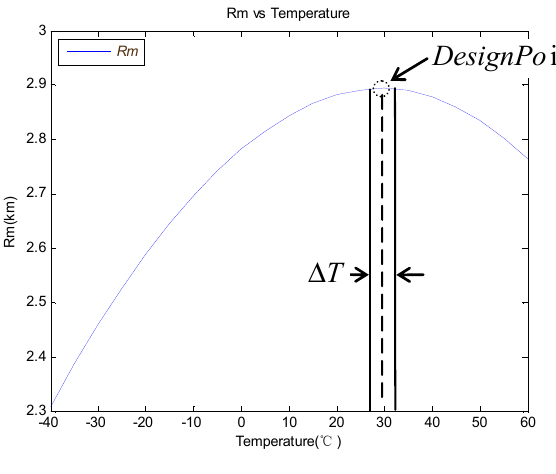
Figure 8. R M _ MAX versus temperature Figure 8. versus temperature curve.